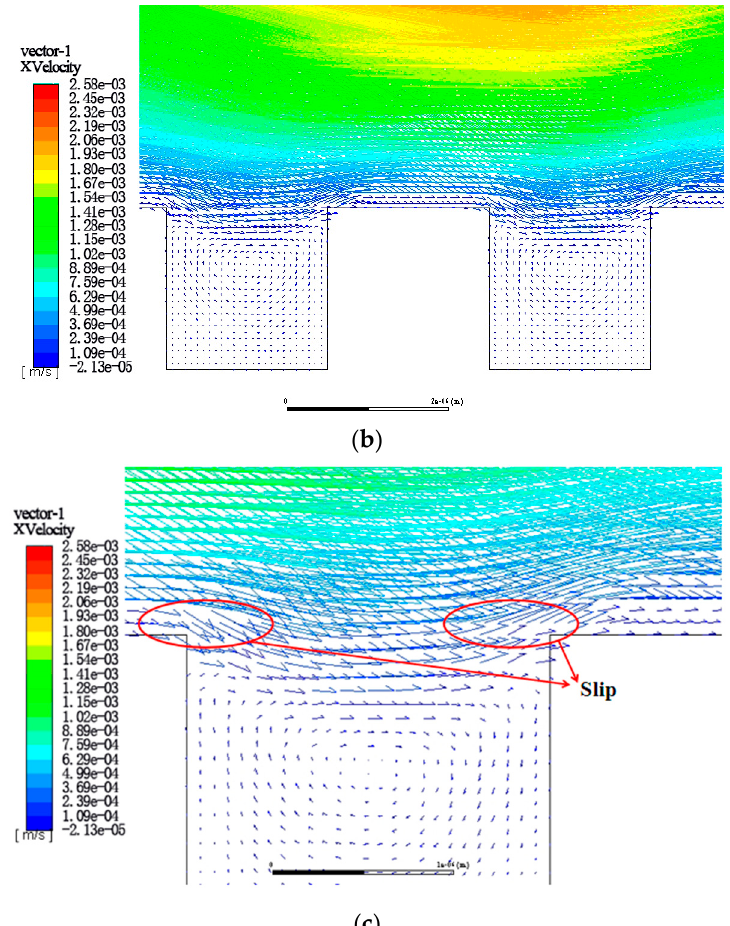
Figure 5. Velocity distribution in the x-direction of the Mp1 microstructural surface. The grey area is the microbial model. The colored and white areas correspondingly represent fluid and microstructure surfaces: ( a ) Velocity nephogram in the x-direction, ( b ) velocity vector diagram of the microstructural surface, and ( c ) partially enlarged figure of the velocity vector in the x-direction. Energies 2018 , 11 , x FOR PEER REVIEW Figure 6 presents the average velocity on the microstructure at d c = 0.1 μ m. When the microorganism started to move, the velocity changed sharply between two periods on the